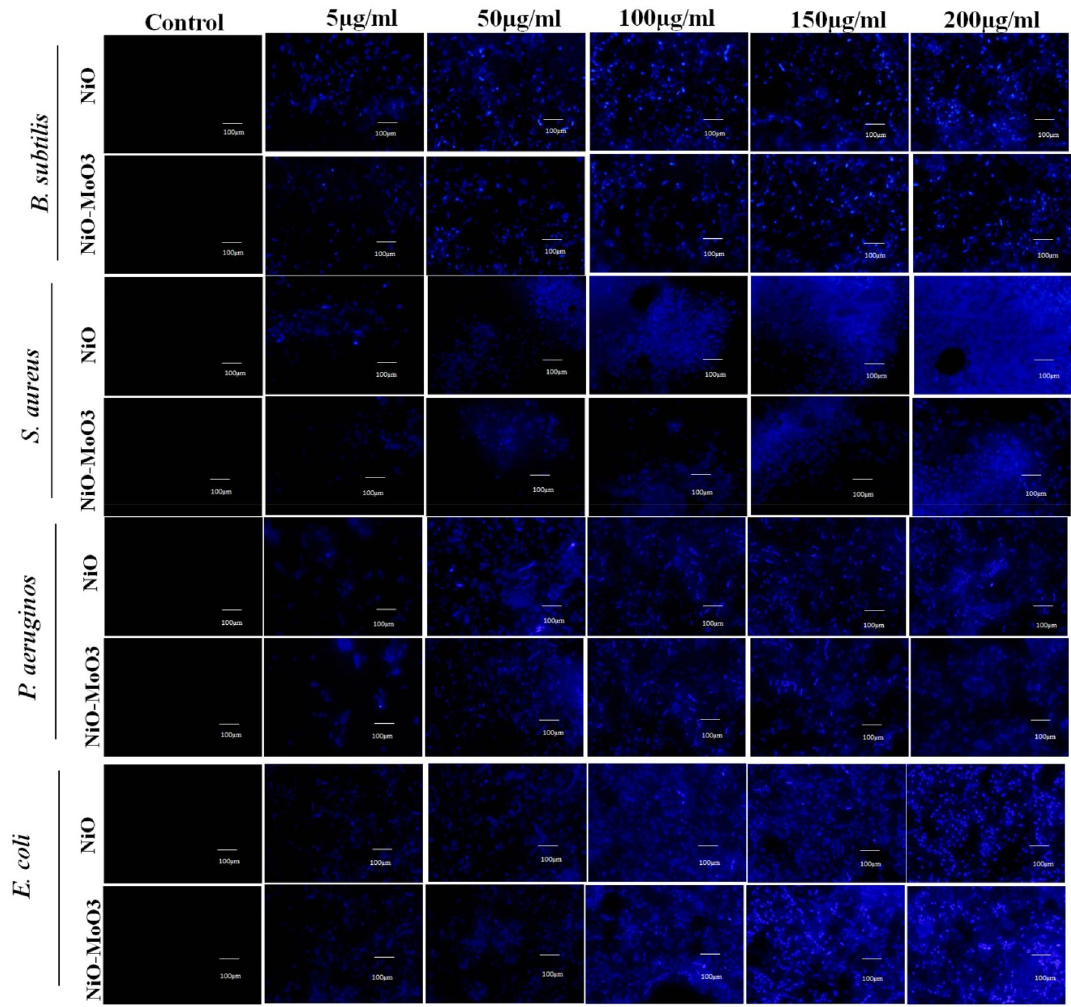
Figure 12. Fluorescence images represented the DAPI staining of bacteria which indicated the increased DNA damage with respect to increase the concentration of NiO NPs and Mo doped NiO ranges from 5 to 200 and it was recorded in the range of 10–90°. The average crystallite size is calculated using Debye Scherrer formula (D = Kλ/βcosθ), where K is the coefficient which have the constant value 0.89, β is full width half maximum, λ is X-ray wavelength. The morphology and average particle size of the material were analyzed by SEM using Bruker with EDX at an operating voltage of 15 kV. The atomic and weight percentages of the constituents was found by EDX analysis. The HR-TEM analysis was performed by JEOL-2100. The optical property was investigated by UV–Vis analysis using a JASCO spectrophotometer and recorded in the range of 200–800 nm with a scanning speed of 1000 nm/min. The FT-IR analysis was done with JASCO FT-IR spectrometer by using KBr as a standard to confirm the formation of metal oxide as well as presence of various functional groups present in the material. Antioxidant. DPPH assay. The DPPH (2,2-diphenyl-1-picryl-hydrazyl-hydrate) free-radical scavenging action of Ni and Mo doped NiO were determined as reported 17 . Briefly, 0.2 mM DPPH was added in methanol and different concentration of Ni and Mo doped NiO (0, 10, 50, 100 and 200 µg/mL) were prepared in methanol. The 50 µL of DPPH solution was added to microtiter plates containing various concentrations of NPs. Then, the reaction mixture was shaken and incubated in dark conditions for 30 min. The absorbance was measured at 570 nm and scavenging activity was calculated as follows: